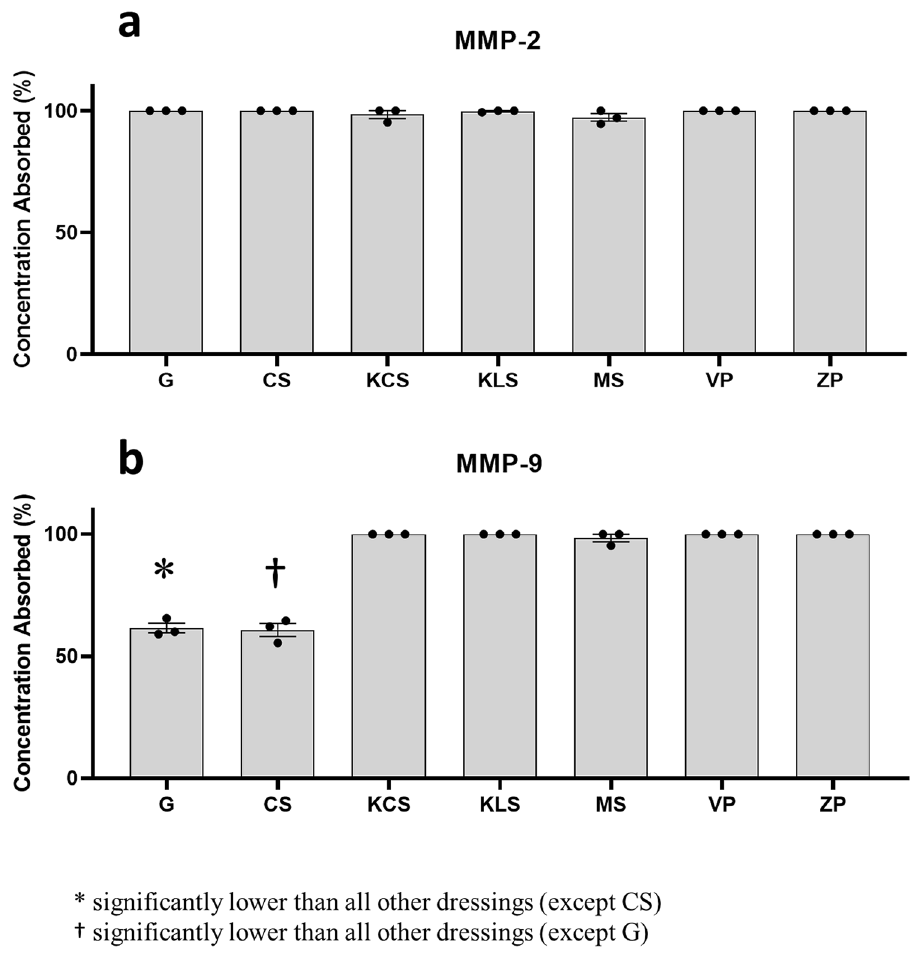
Figure 9. Absorption of MMPs by wound dressings. Wound dressings were inoculated with a solution of either MMP-2 or 9 at 6 ng/ml. Dressings were incubated for 4 days, the supernatant collected and the remaining concentration of each MMP was determined via enzyme-linked immunosorbent assay (ELISA). The following dressings were tested: Gauze (G), ConvaMax Superabsorber (CS), 3M Kerramax Care Super-Absorbent Dressing (KCS), Kliniderm Superabsorbent (KLS), Mextra Superabsorbent (MS), Vliwasorb Pro (VP) and Zetuvit Plus (ZP). Data for MMP-2 ( a ) and MMP-9 ( b ) is shown as percentage MMP absorbed (+ /− SEM, n = 3). Figure produced in GraphPad Prism